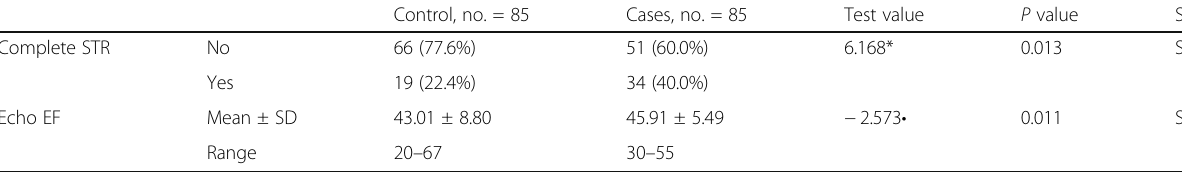
Table 5 Comparison between cases and controls regarding electrocardiography and echocardiographic parameters Control, no. = 85 Cases, no. = 85 Test value P value Sig.